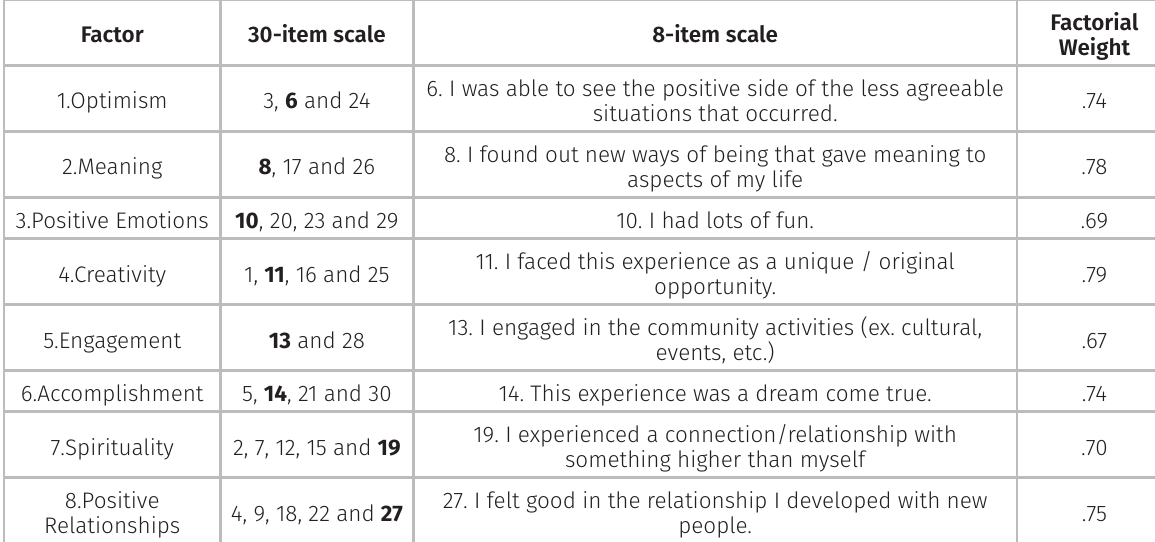
Table I. Factorial weights for the eight items.